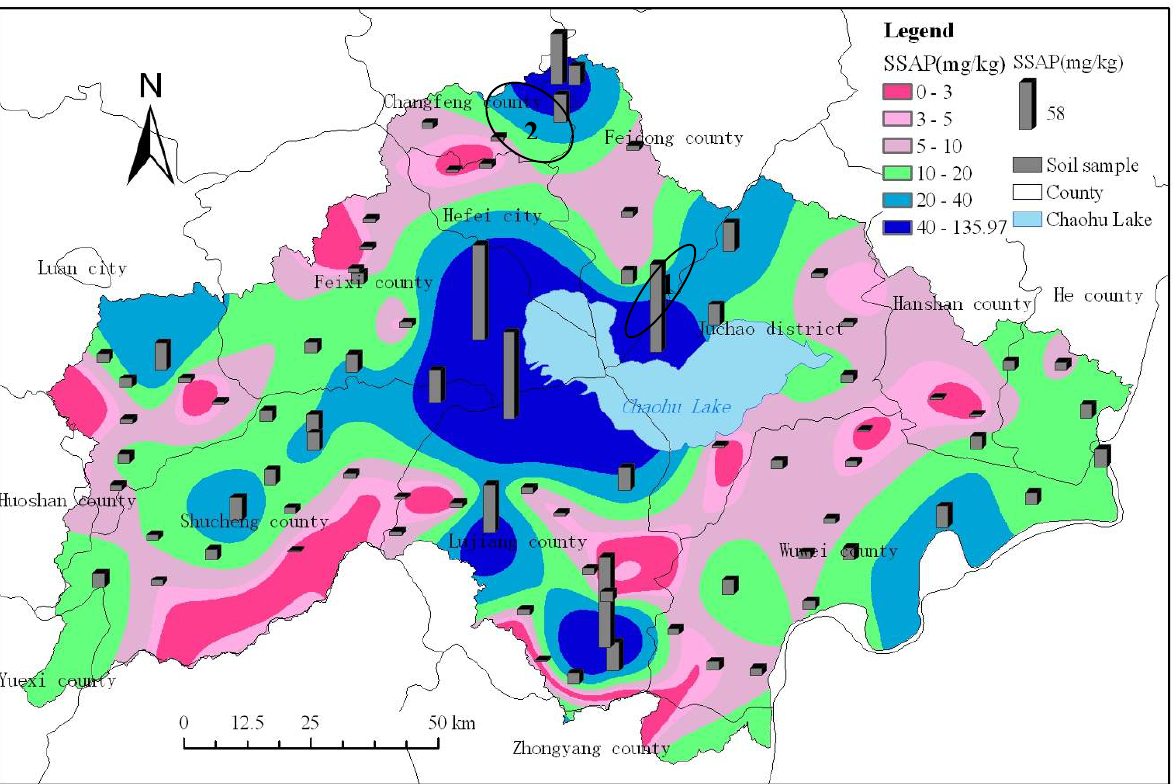
Figure 4. Spatial distribution of surface soil available phosphorus (SSAP) in the Chaohu Lake